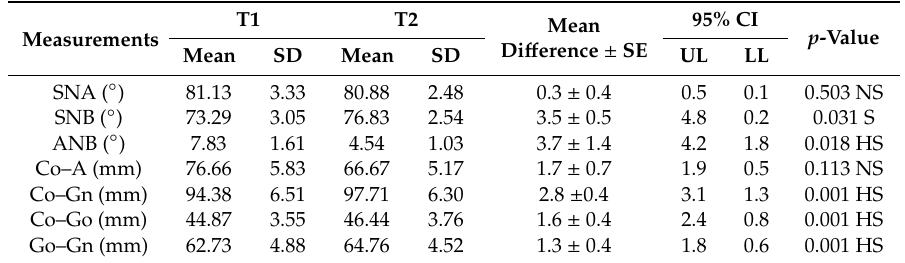
Table 7. Comparison of lateral cephalometric skeletal measurements before and after twin block therapy in control group using paired t -test.